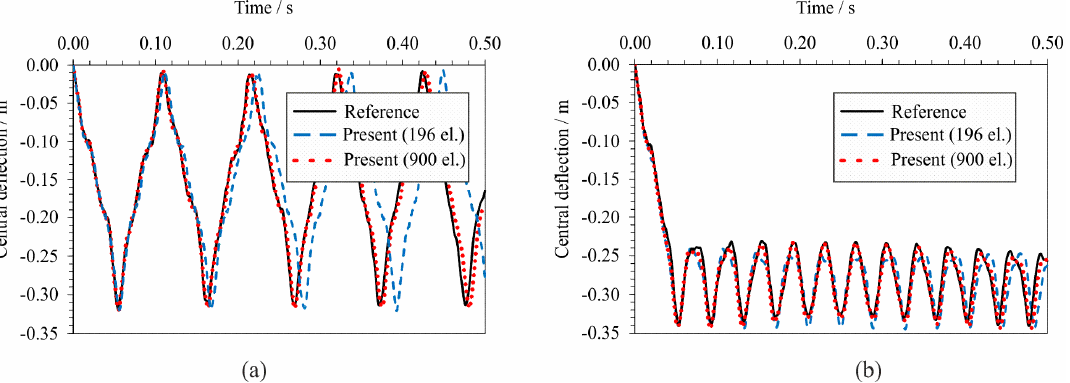
Figure 21. Load-deflection curves of the hinged cylindrical roof for: ( a ) linear-elastic material; ( b ) nonlinear material.